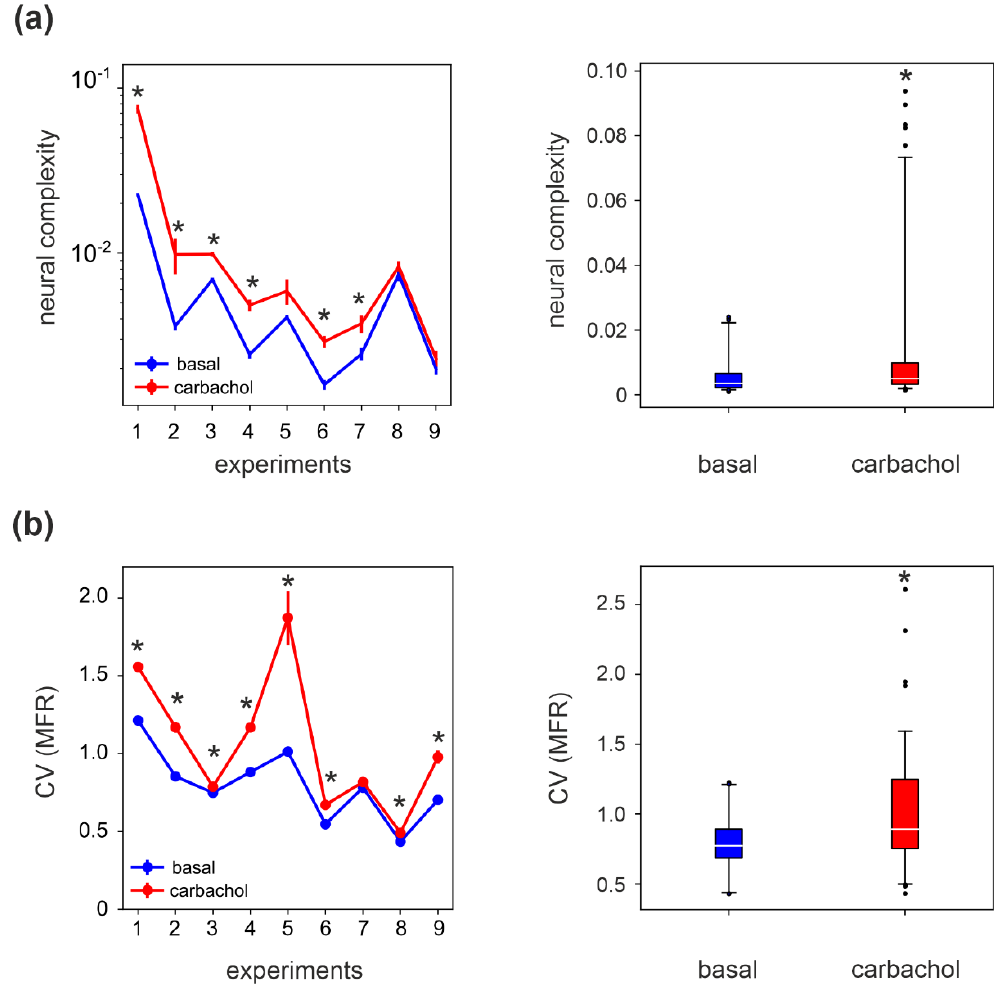
Figure 4. Complexity measures of spontaneous activity. ( a ) Left panel: The neural complexity (NC) during CCh is significantly higher than in the basal condition, in 6 out of the 9 experiments (* p < 0.05, t -test). Mean and SEM are estimated in sessions of 5 min. Right panel: NC is significantly higher during CCh at the population level ( p = 0.013, two-way ANOVA with factor drug treatment). ( b ) Left panel: The coefficient of variation (CV) of the channel mean firing rates is significantly higher in CCh with respect to the basal condition in all experiments (* p < 0.01, t -test). Right panel: CV(MFR) is significantly higher during CCh at the population level ( p = 10 − 4 , two-way ANOVA with factor drug treatment). In the boxplots, the white line corresponds to the mean of the distribution, the lower/upper sides of the box to the first/third quartiles, and the lower/upper whiskers to the 5th/95th percentiles. Black dots in the right panels are outliers, falling below the 5th percentile or above the 95th percentile.